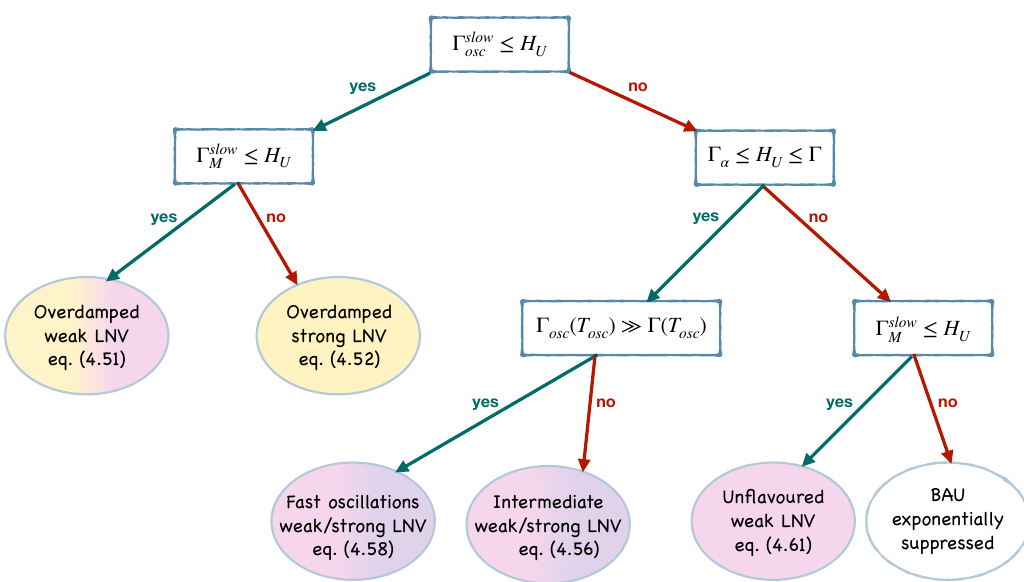
Figure 4 . Chart summarizing the analytical solution in each washout regime. The interaction rates and the Hubble expansion rate need to be evaluated at T